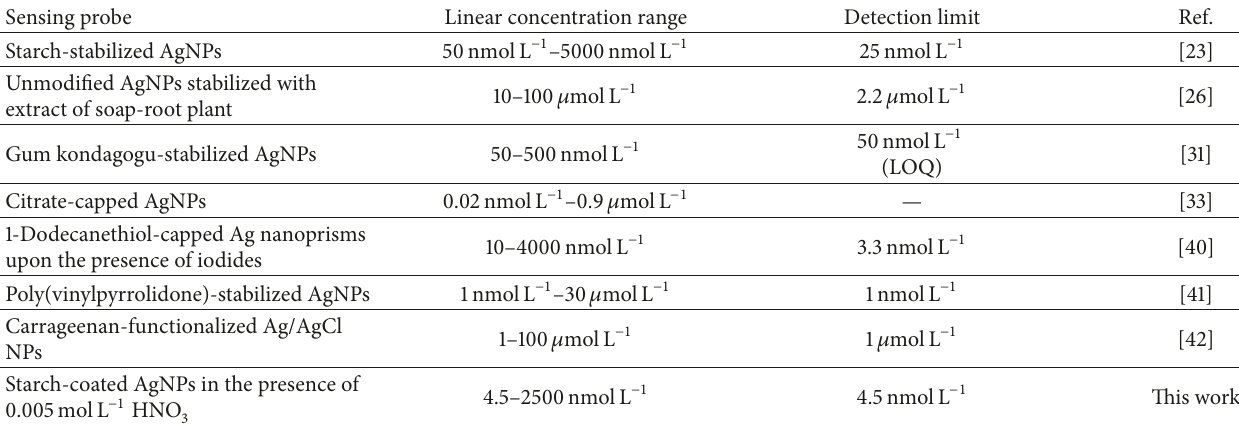
Table 2: Comparison of different methods using silver nanoparticles as a colorimetric sensing probe for Hg 2+ determination. Sensing probe Linear concentration